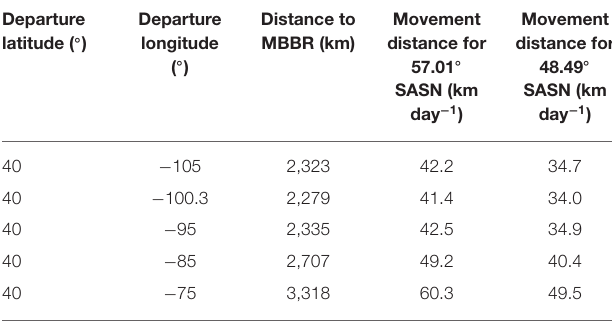
TABLE 2 | Average daily movement distance (km day − 1 ) needed to maintain a constant Sun Angle at Solar Noon (SASN) when leaving from different longitudes but from a constant latitude (40 ◦ ) on the journey to the Monarch Butterfly Biosphere Reserve (MBBR) in Mexico.